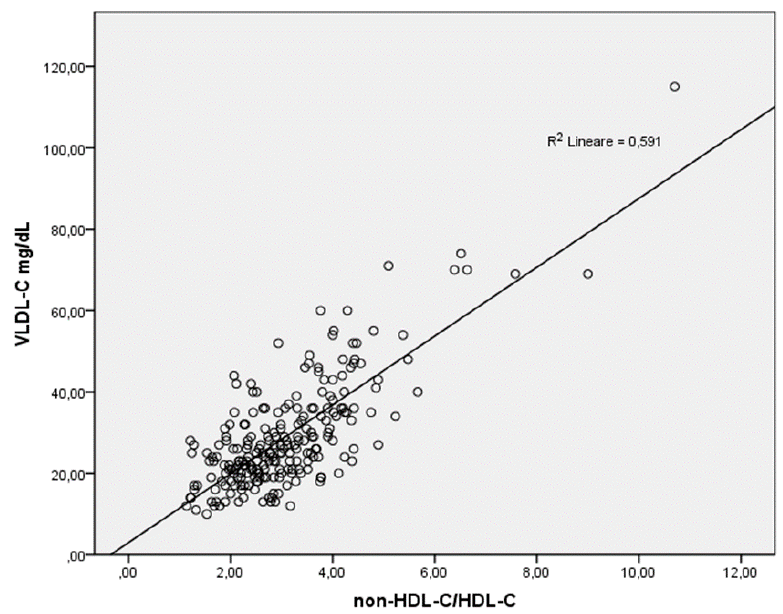
Figure 1. Correlation between non-HDL-C/HDL-C and VLDL-C.